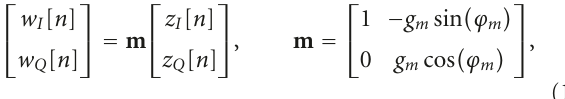
Figure 1. Note that the digital-to-analog converter